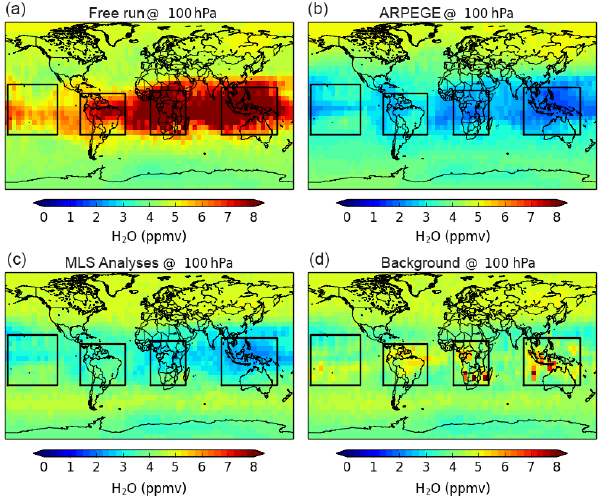
Figure 8. Monthly averaged H 2 O fields at 100hPa in January 2012 in the MLS observation space (in time and space coincidence with MLS observations) from the free run (MOCAGE, a ), ARPEGE (b) , MLS analyses (assimilation, c ) and the background (d) .